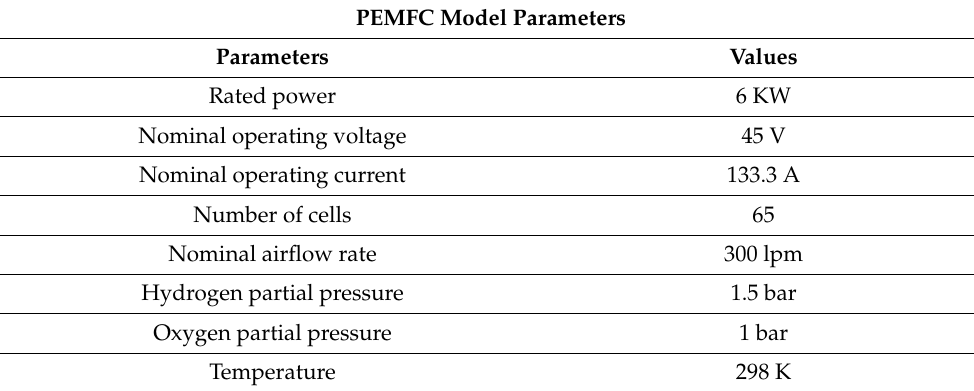
Table 1. PEMFC model